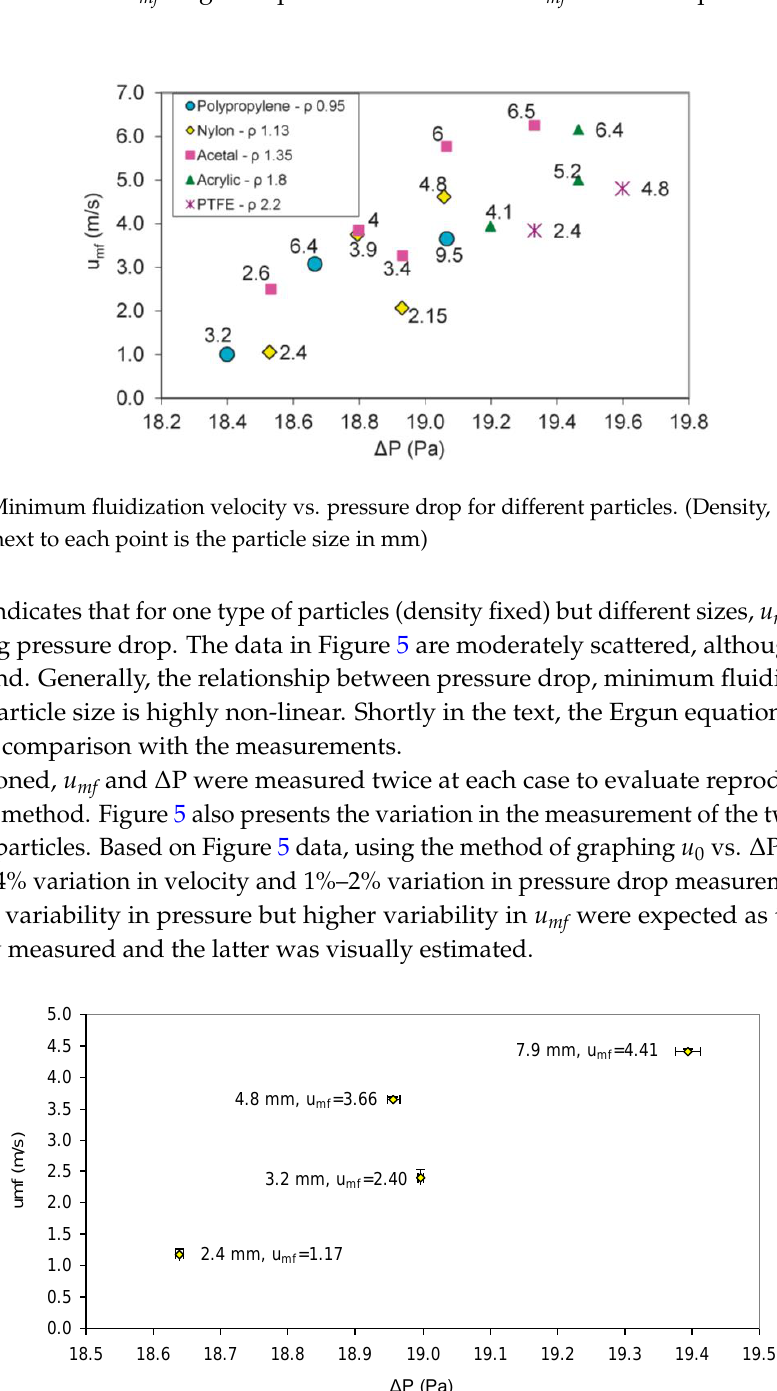
Figure 6. Reproducibility of u mf estimation method for different particle sizes (particles diameter are given in mm).